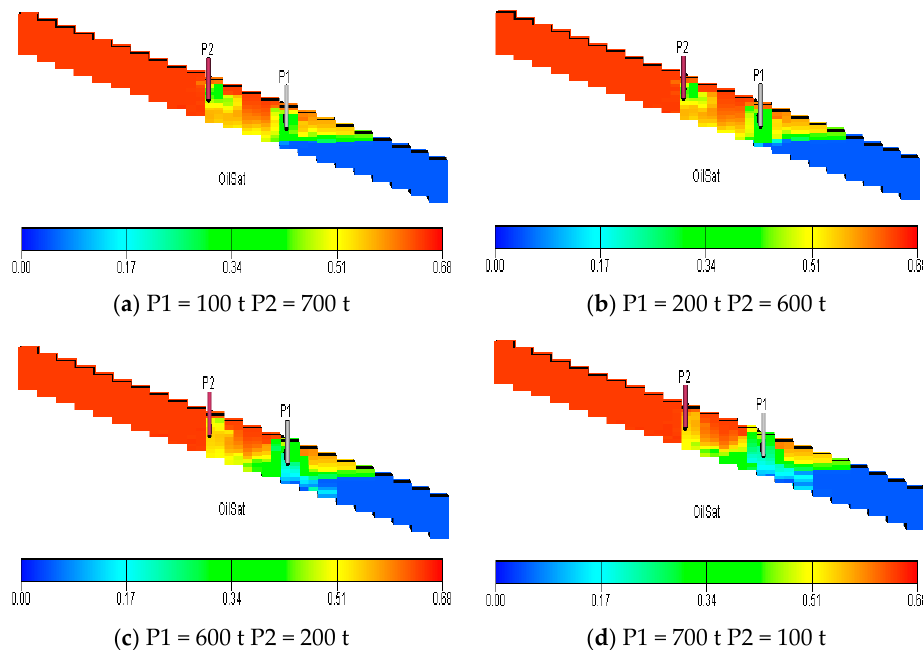
Figure 18. Distribution of oil saturation after validity period.